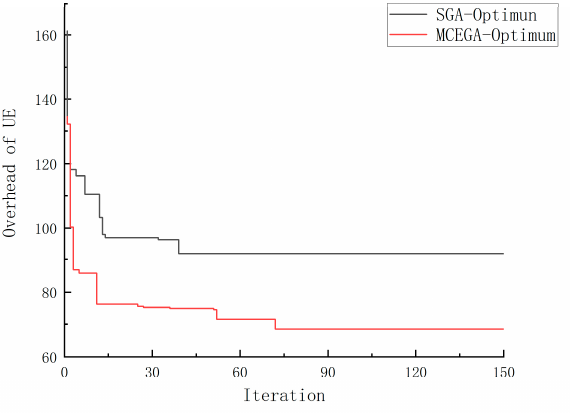
Figure 7. Convergence comparison between MCE-GA and SGA.